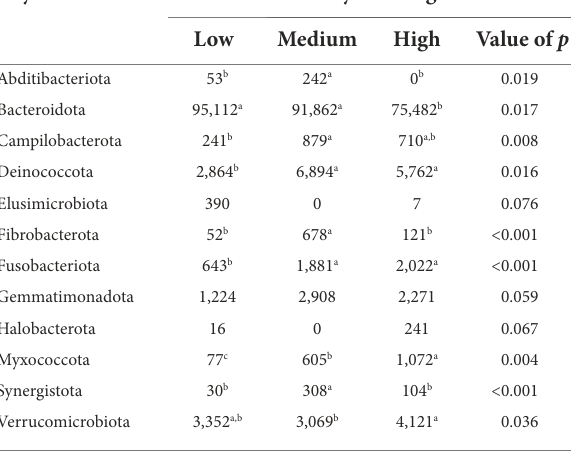
TABLE 4 Bacterial phyla relative abundance (ppm) in the milk samples of Holstein dairy cattle associated with different milk yield ranges at time of collection: low, medium, and